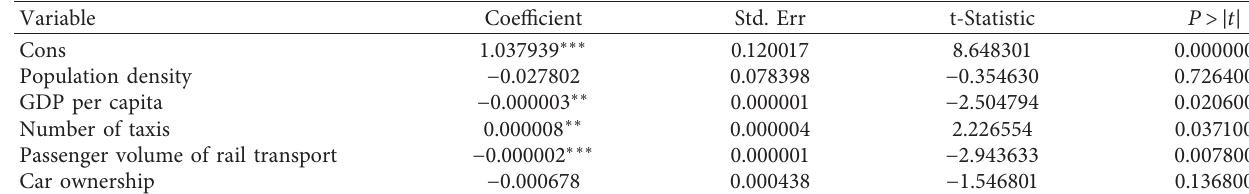
Table 6: Tobit regression